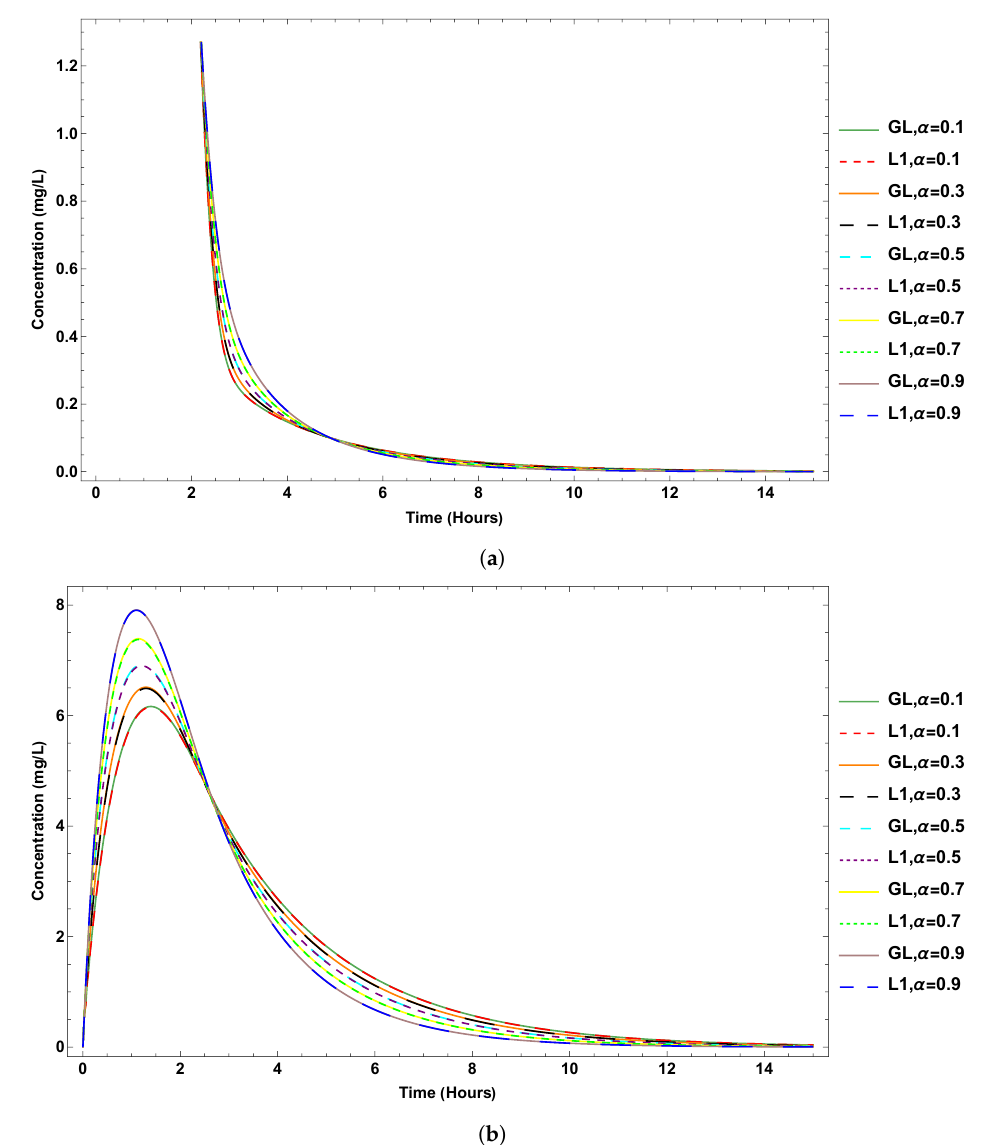
Figure 2. The IV bolus administration route model, as a function of time, is fixed, along with several α values. ( a ) The central compartment concentration. ( b ) The peripheral compartment